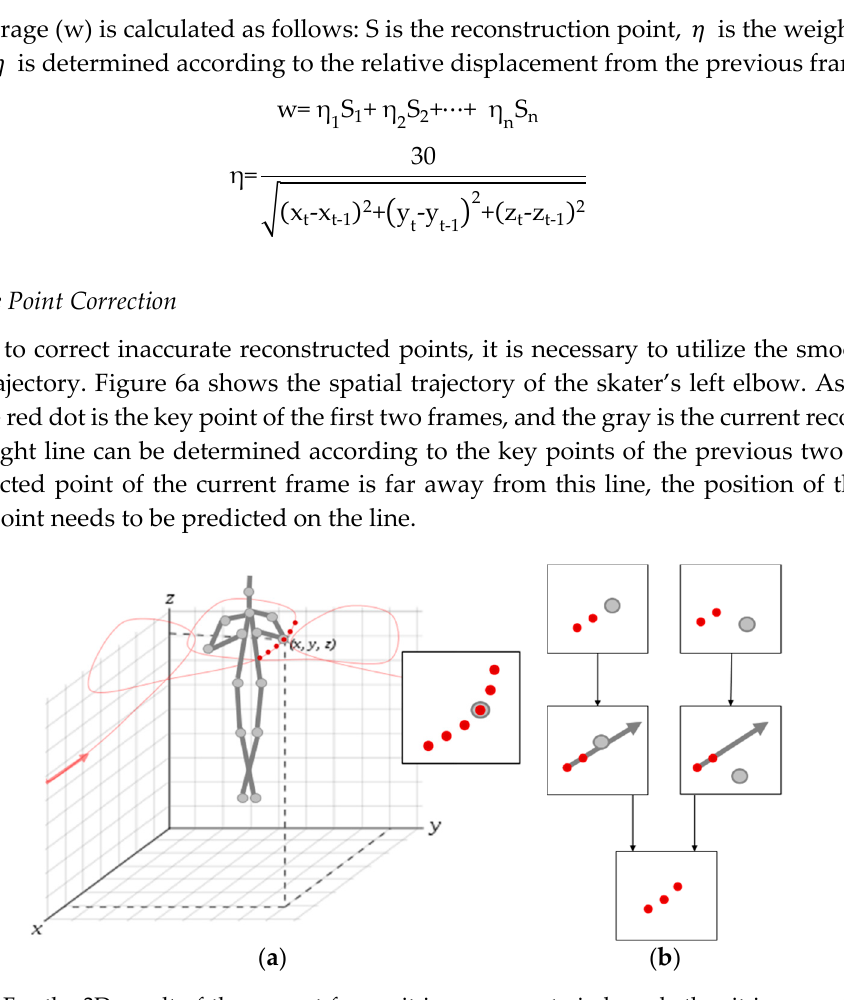
Figure 6. For the 3D result of the current frame, it is necessary to judge whether it is accurate. An inaccurate spatial point requires a suitable predictive value. ( a ) The spatial trajectory of the left elbow; ( b ) determination and prediction of key